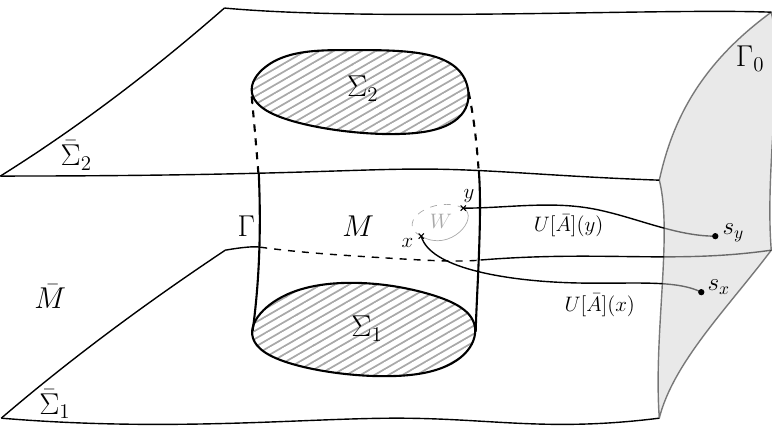
Figure 3 . The spacetime region M and its complement. From a system of Wilson lines { γ x } anchored at asymptotic source { s , we construct the dynamical edge field U [ ¯ A ] , which provides a x } reference frame for the time-like boundary Γ . It allows us to decompose gauge-invariant observables with support on both M and ¯ M , such as the Wilson loop W , into composites of regional gauge- invariant